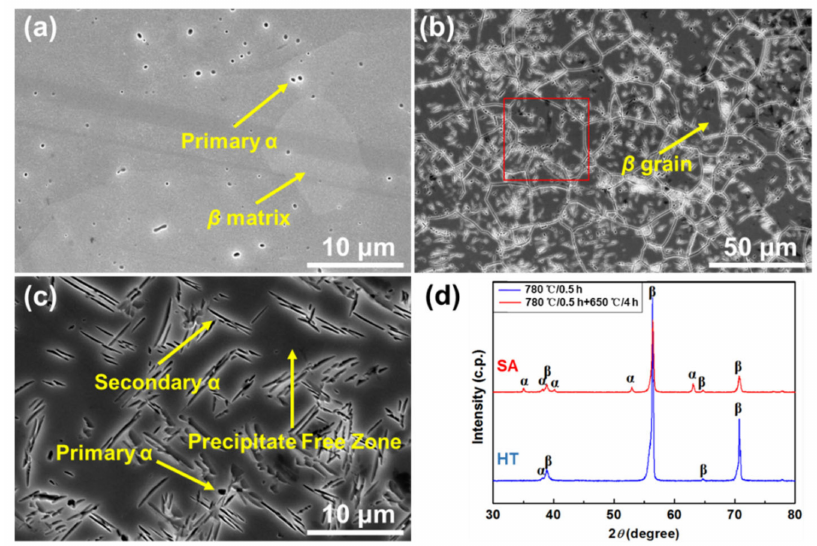
Figure 2. Microstructures of the alloy after heat treatment: ( a ) HT (solution treatment), ( b , c ) SA (first- step aging), ( d ) XRD (X-ray diffraction) patterns of HT (solution treatment) and SA (first-step